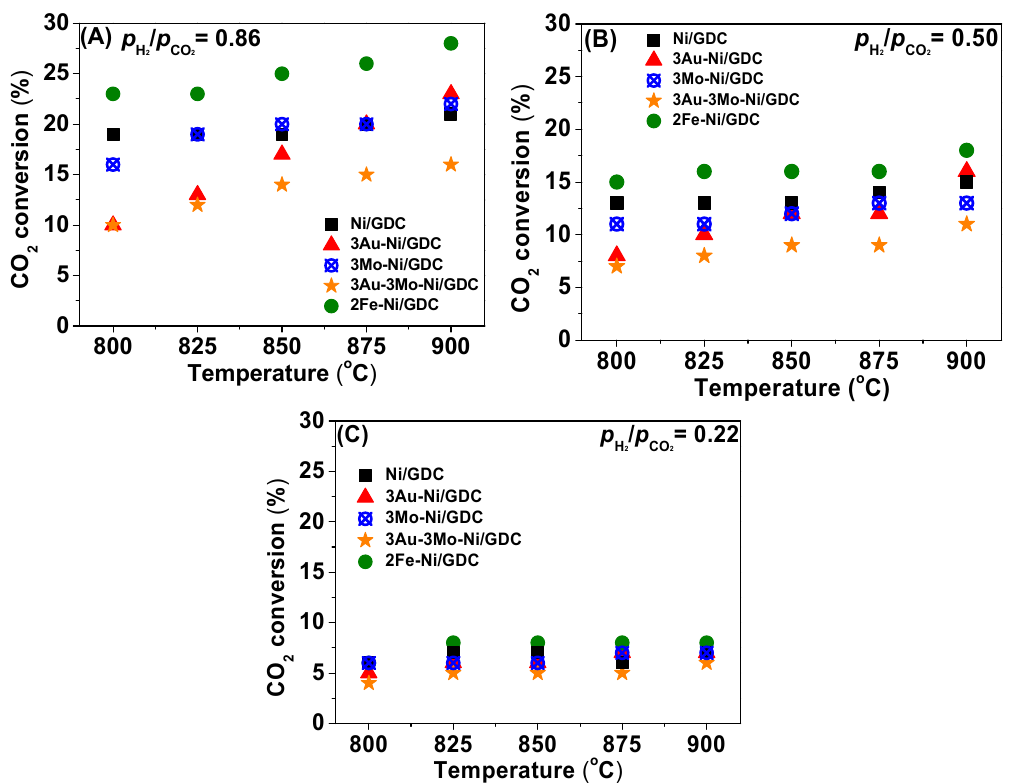
Figure 5. The corresponding %CO 2 conversions of ESCs comprising: Ni/GDC, 3Au- Ν i/GDC, 3 Μο - Ν i/GDC, 3Au–3 Μο - Ν i/GDC, and 2Fe-Ni/GDC, as fuel electrodes, in the range of 800–900 °C under three different mixtures: ( A ) 24.5% H 2 O - 24.5% CO 2 - 21% H 2 (P H2 /P CO2 = 0.86), ( B ) 28% H 2 O - 28% CO 2 - 14% H 2 (P H2 /P CO2 = 0.50), and ( C ) 31.5% H 2 O - 31.5% CO 2 - 7% H 2 (P H2 /P CO2 = 0.22). Dilution of He: 30 vol.% and F total = 140 cm 3 /min (at STP conditions: 0 °C, 1 atm) in all cases. All studied electrodes have similar loading in the range of 10–12 mg/cm 2 .